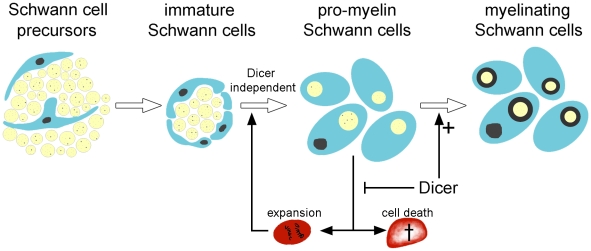
The role of Dicer and miRNAs in Schwann cell development.In the absence of Dicer, Schwann cells develop normally to the pro-myelin stage with properly sorted axons (light yellow). The presence of Dicer is required for acquisition of myelination competence by Schwann cells (turquoise). When Dicer is removed from Schwann cells (red), reduction of miRNAs leads to Schwann cell hyperproliferation and degeneration, suggesting that miRNAs are essential both for driving maturing Schwann cells into cell cycle arrest and terminal differentiation, as well as for their survival.